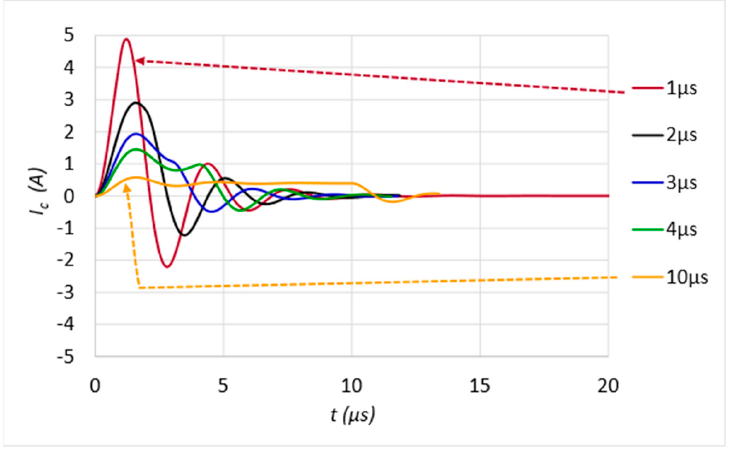
Figure 10. Simulated transient current waveforms of the capacitor element for slip times of 1, 2, 3, 4 and 10 µs. Signals with shorter slip times have a larger overshoot.